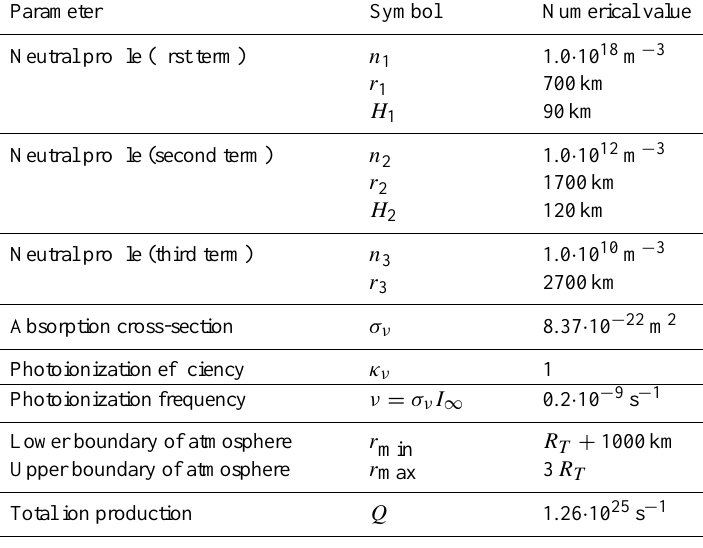
Table 1. Input parameters for the ion production profile according to Eq. (14). The radius of Titan is R T =